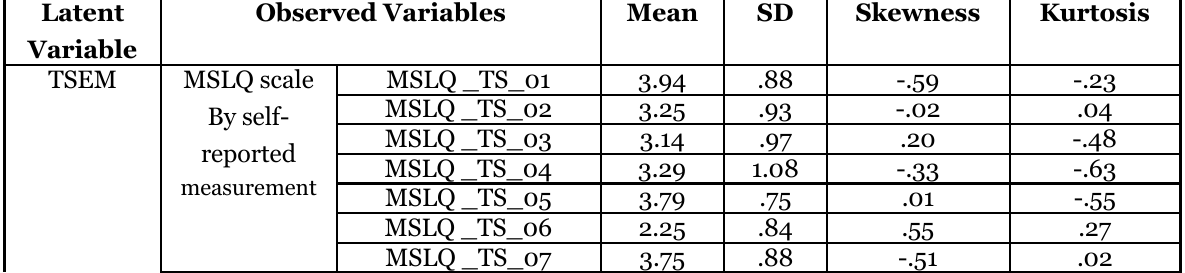
Descriptive Statistics (N=124) Latent